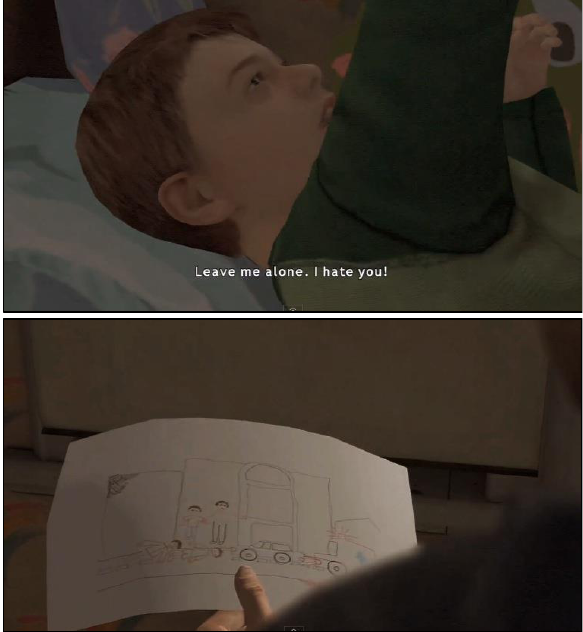
Figure 5 | Heavy Rain is not a movie because story changes accordingly to actions and choices [2]. Pictures from Heavy Rain .